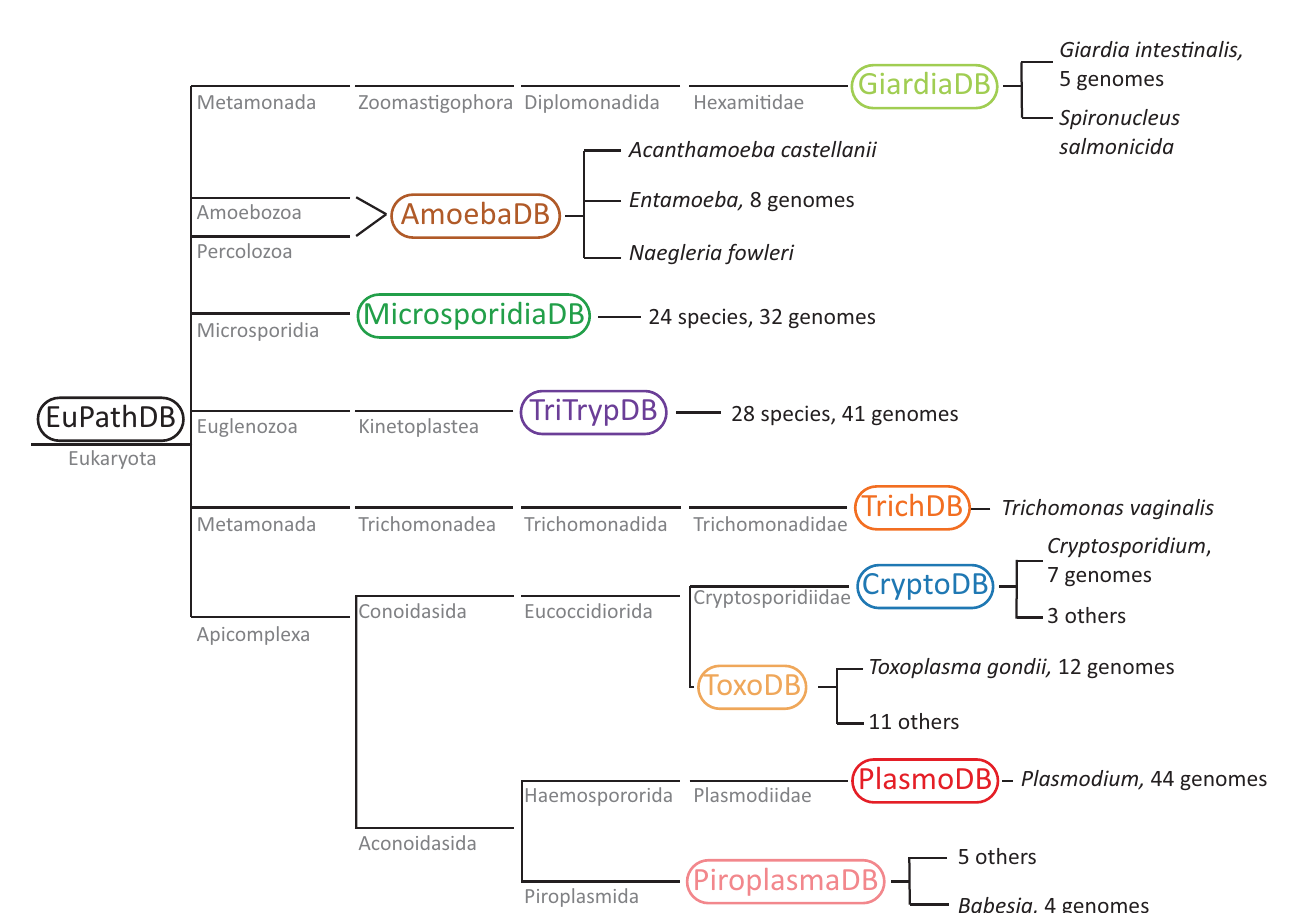
Fig 1. EuPathDB databases. EuPathDB is the Eukaryotic Pathogens database and serves as a repository for parasite ‘omics data; EuPathDB contains field- specific databases including GiardiaDB, AmoebaDB, MicrosporidiaDB, TriTrypDB, TrichDB, CryptoDB, ToxoDB, PlasmoDB, and PiroplasmaDB ( all shown ), as well as FungiDB, HostDB, and MicrobiomeDB. Here, a phylogenetic tree of database member parasites is shown (lines are not to scale). Each EuPathDB sub-database is in a rough phylogenetic grouping, but the parasites on the EuPathDB databases are genetically and phenotypically highly diverse. Database color-coding shown here will be used through other